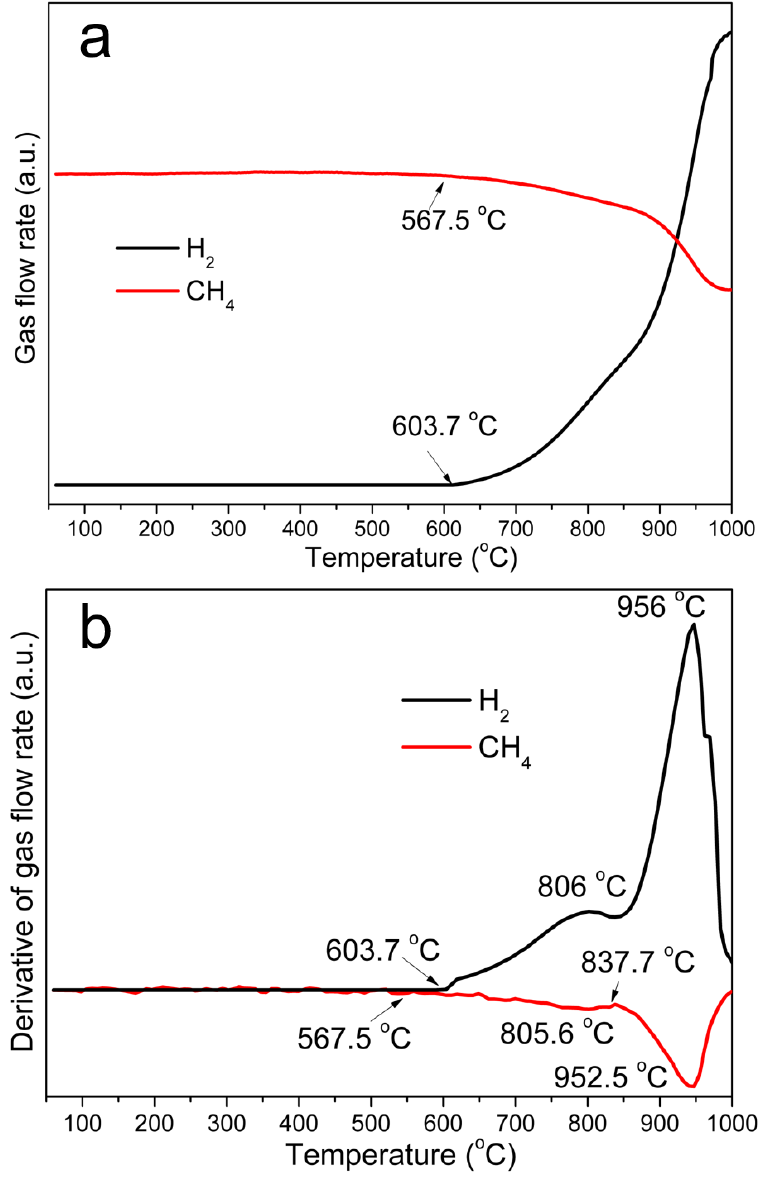
Figure 5. Flow rates ( a ) and their derivatives ( b ) of methane and hydrogen in the vent gas during the temperature-programmed MCW reaction. Feed gas: 50-mL/min Ar–80-mL/min CH 4 ; heating rate, 10 C/min; 50-g GEINs loaded to the reactor.